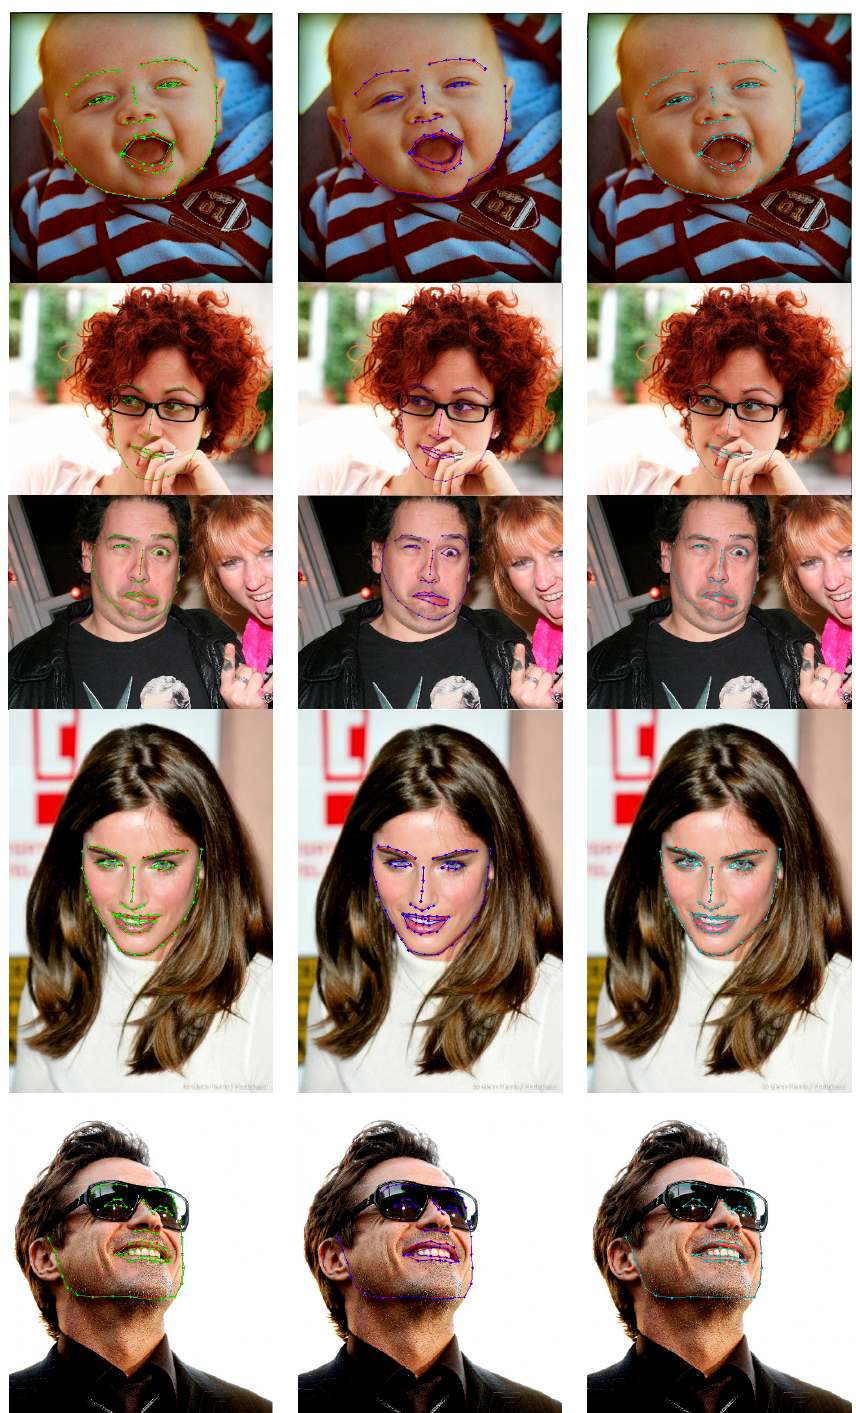
Figure 8. Face alignment results for different methods on the 300 W dataset [12]. The left column shows the results with our compressed training model. The center column shows the results by using the SDM algorithm with an uncompressed training model [6]. The right column shows the results with the 2D-FAN [22].